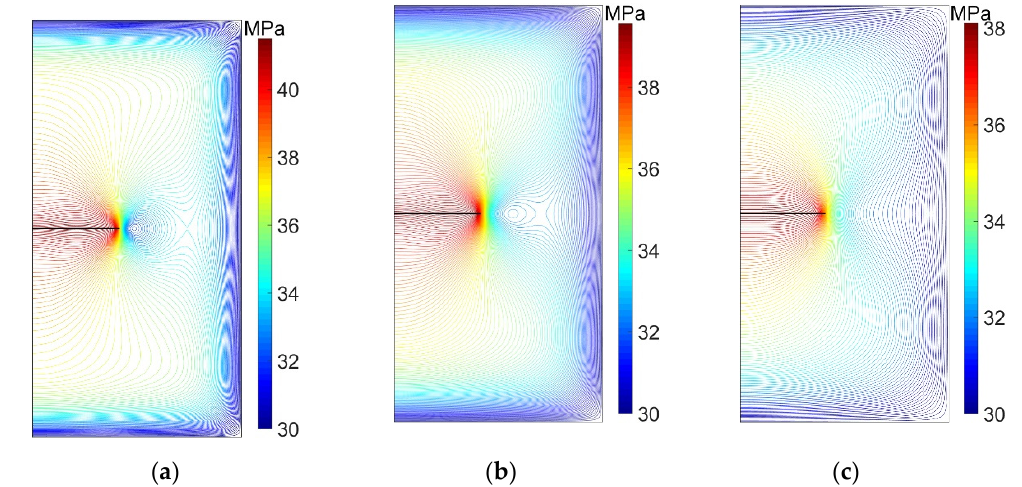
Figure 14. Contours of pore pressure in matrix ( t = 358s): ( a ) k m = 5 mD; ( b ) k m = 10 mD; and ( c ) k m = 20 mD.